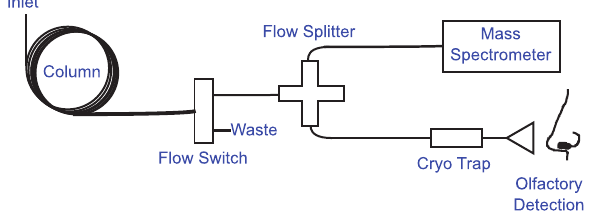
Figure 1. Conceptual schematic of the Gas Chromatograph Recomposition-Olfactometer (GC-R) instrument. Volatiles are extracted onto a solid phase (via solid-phase microextraction or SPME) from the headspace of a food, beverage, or other sample, in this case, lavender flowers, and initially they are separated conventionally on an analytical capillary GC column. In-line with the GC column, a pneumatic Deans Switch followed by a cold trap allows the experimenter to build a mixture of these separated volatiles that is held until the cryotrap is rapidly heated, releasing the mixture for a subject to smell at the olfactory port and